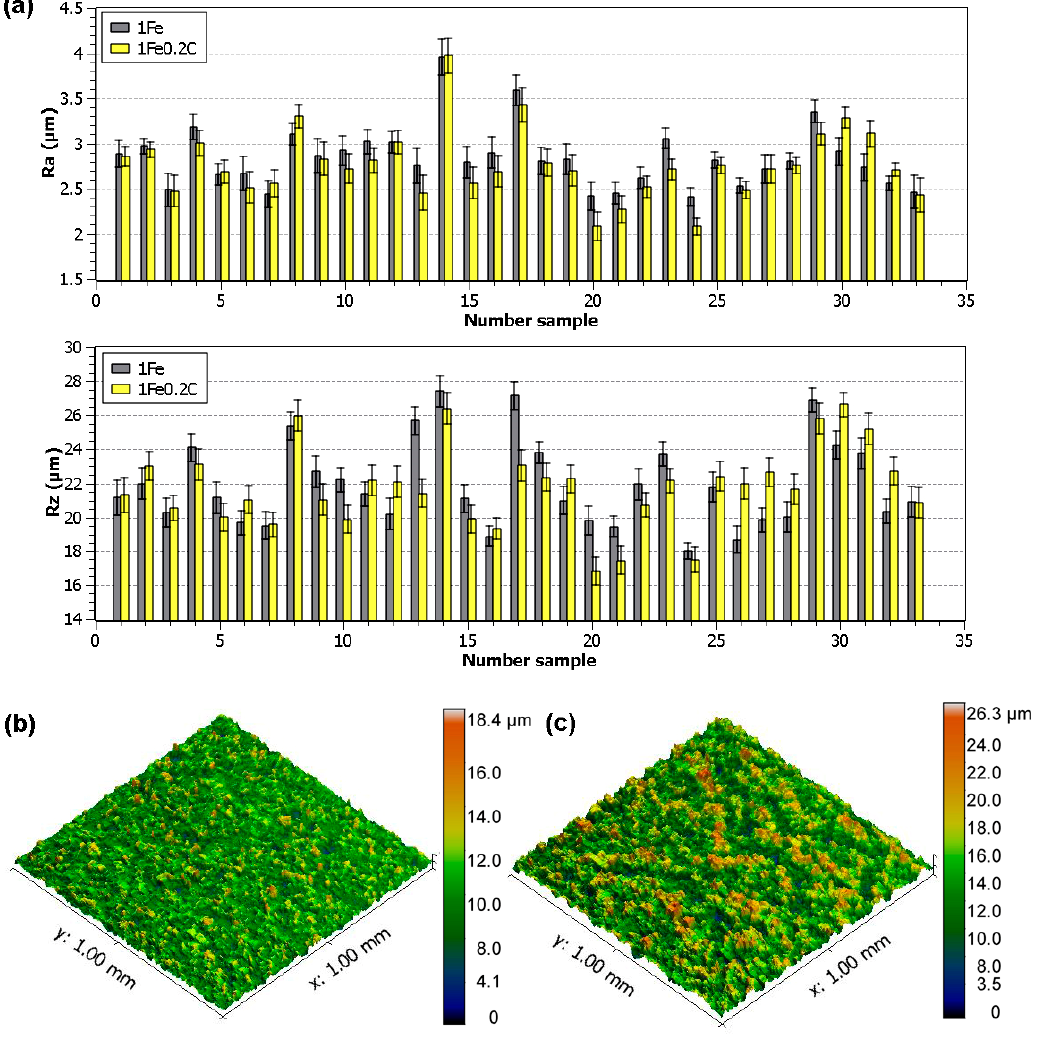
Figure 3. ( a ) The evaluated surface topography parameters Ra and Rz of individual experimental samples, ( b ) 3D relief of Sample 20 made of 1Fe0.2C, ( c ) 3D relief of Sample 14 made of 1Fe alloy.